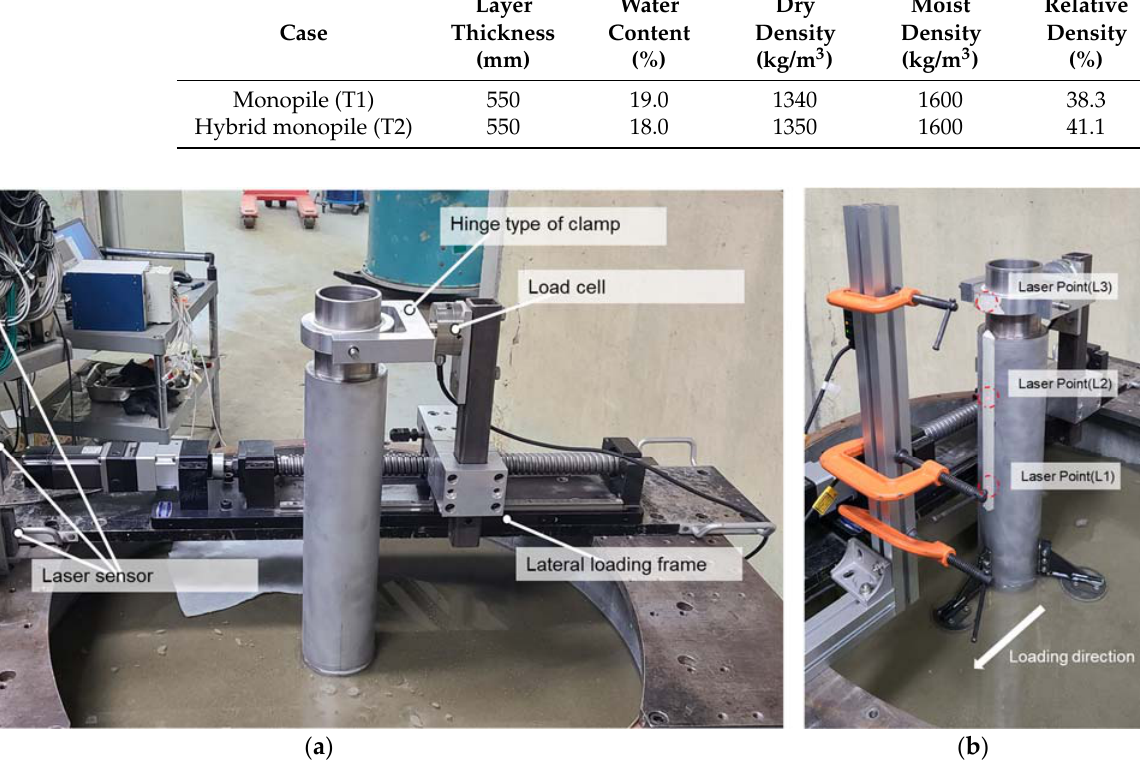
Table 3. Fundamental properties of soil foundation for conventional and hybrid monopiles.